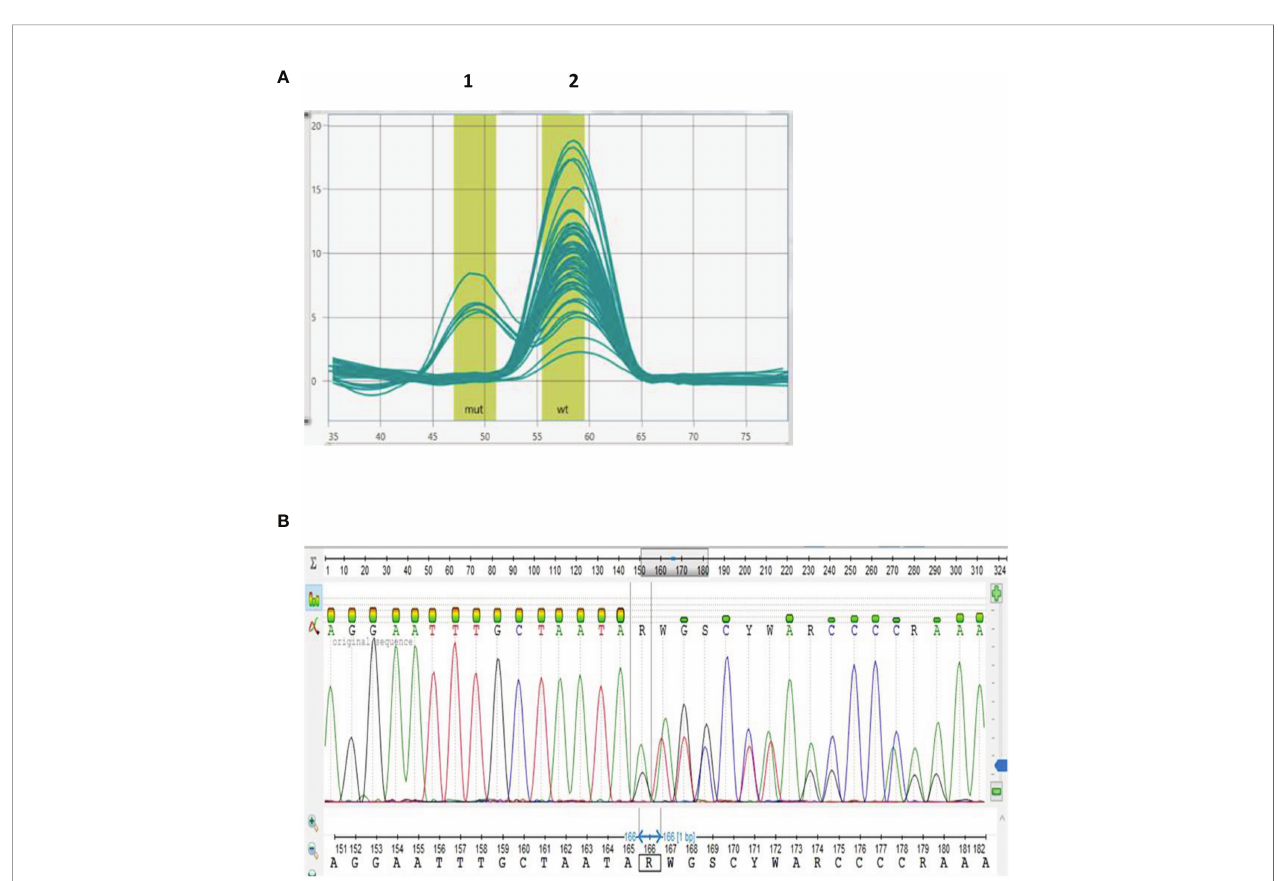
FIGURE 3 | Genotyping of breast cancer patient samples using the BRCA 1.0 POC Research Assay designed to detect eight BRCA1/2 founder/recurrent South African pathogenic variants. Melting curve analysis of BRCA2 c.7934delG (A) with the CAL 560 probe indicating the presence of a second melting peak (peak 1) for six samples ( fi ve patients and the positive control). No pathogenic variants were detected in 45 DNA samples (peak 2). Detection of BRCA2 c.7934delG was con fi rmed by Sanger sequencing (B)